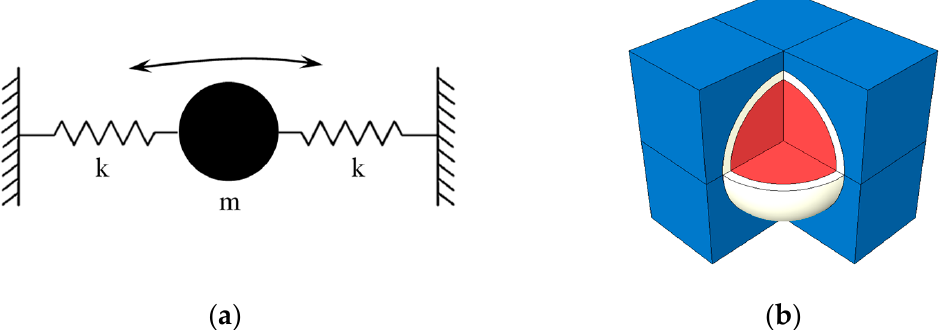
Figure 4. The core-coating inclusion and its equivalent models. ( a ) SDOF mass-spring system. ( b ) 3D FE-Model.